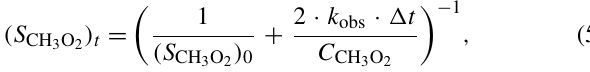
algorithm. Figure 1 shows an example CH 3 O 2 self-reaction decay trace obtained at 1000 mbar, where the red line shows the result of the fitting